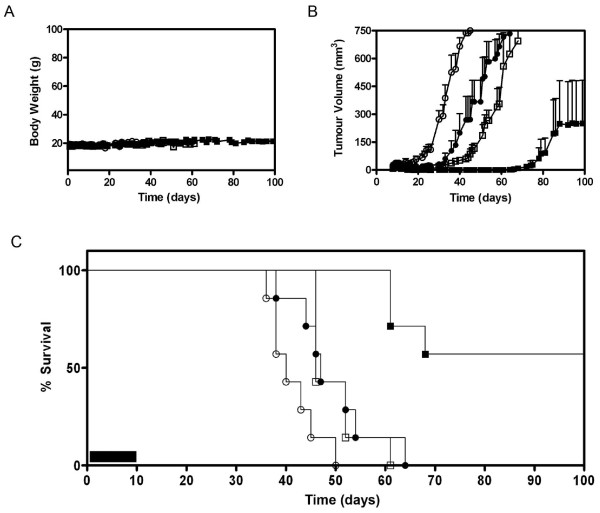
In vivo results following treatment regimens in SCID mice harboring established 518-A2 tumor xenografts. The regimens included 10-day, daily injections of a saline control (i.v) (white circles) or SLT-1AIYSNKLM (i.v. 0.5 mg/kg) (black circles), or a 5-day course of DTIC (i.p. 8 mg/kg) (white squares), or the combination of both SLT-1AIYSNKLM (i.v. 0.5 mg/kg) with DTIC (i.p. 8 mg/kg) regimens (black squares), (n = 7). (A) Mice showed no change in body weight related to treatment regimens over time. (B) Measured tumor volumes of mice demonstrate a significant synergistic effect of combining SLT-1AIYSNKLM and DTIC treatments when compared to either treatment alone or to the saline control (P < 0.0001). (C) Kaplan-Meier plot comparing animal survival as a function of treatment regimens (ten-day regimen; black bar).